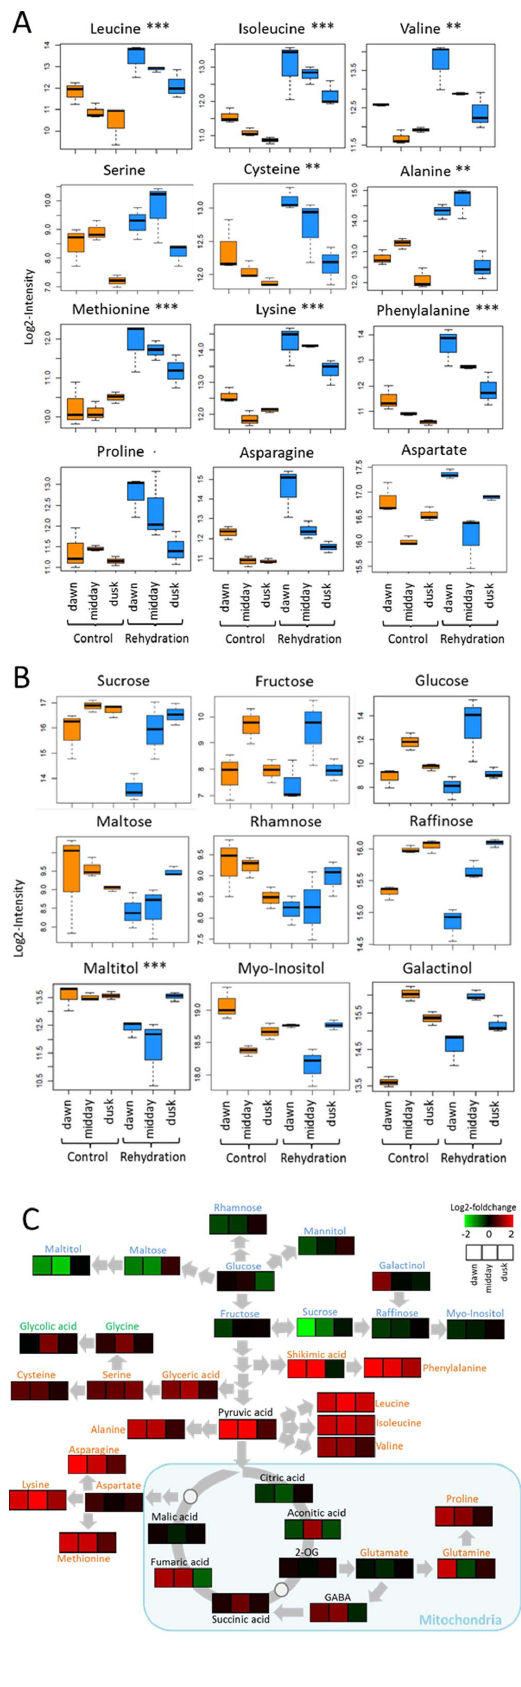
Figure 3. Boxplots and pathway visualization of representative primary metabolites. ( a ) and (b): Boxplot-visualizations for a subset of amino acids (A) and sugars and sugar alcohols(B) as determined for the three independent samples for the different time points and treatments as indicated on the x-axis. (b) Pathway mapping of a number of primary metabolites visualized as their averaged log2- foldchange ratio of rehydration versus control (green = decrease; red =